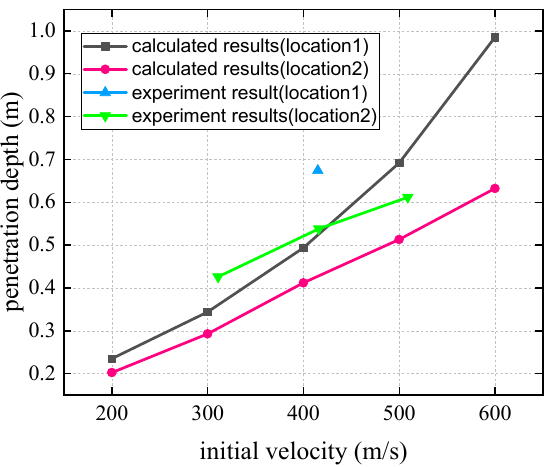
Figure 14. The relationship between the penetration depth and impact velocity of projectile.